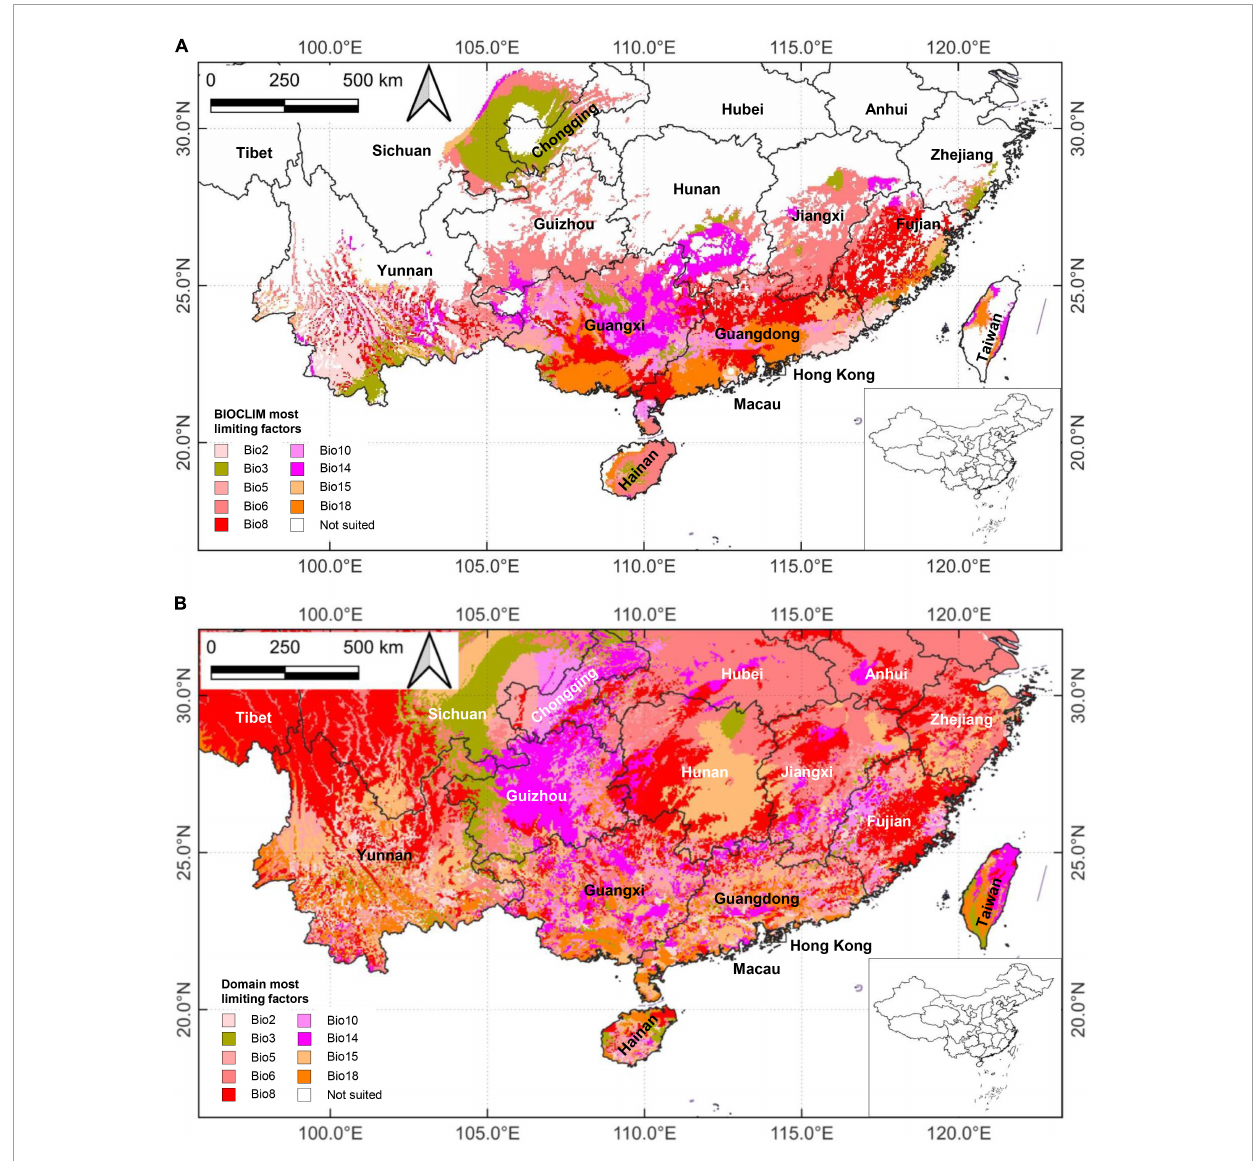
FIGURE3 Distribution patterns of the limiting factors shaping the distribution areas of Mimosa bimucronata generated by the: (A) BIOCLIM model; and (B) DOMAIN model. The selected nine bioclimatic variables, shown in different colors, had the greatest impact on predicting suitable habitats in the distribution area. The meaning of the bioclimatic variables can be found in Supplementary Table 1